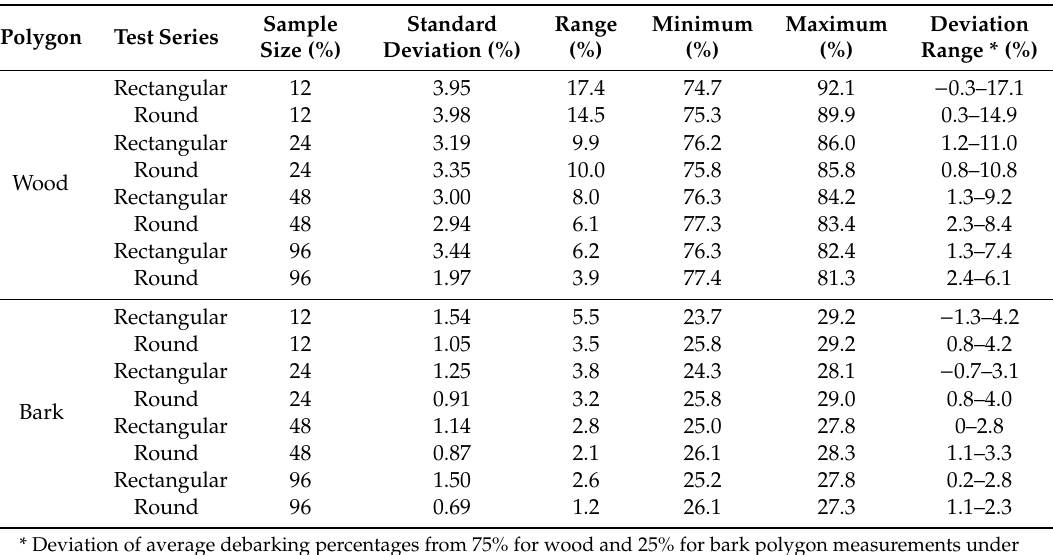
Table 3. Descriptive statistics presenting the main results comparing the calculated average debarking percentages.